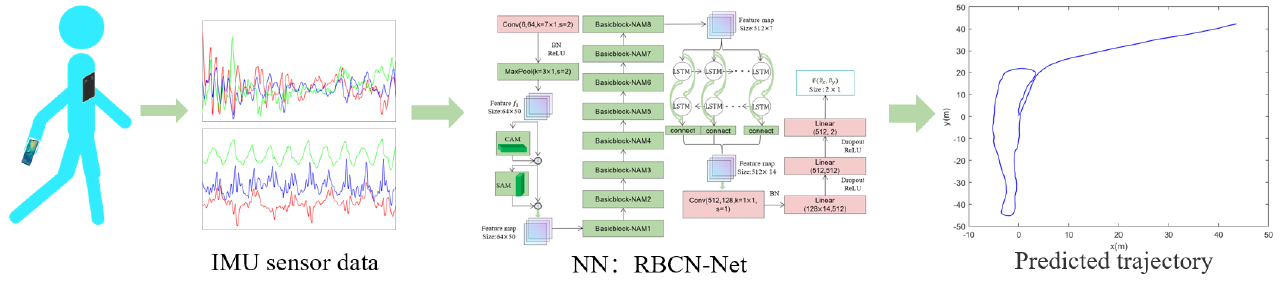
Figure 1. Overview of the